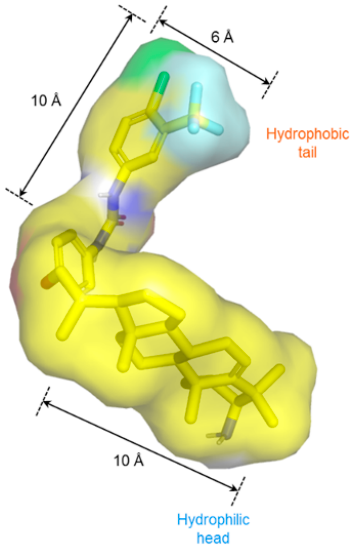
Figure 4. Geometric property of compound 5ba .